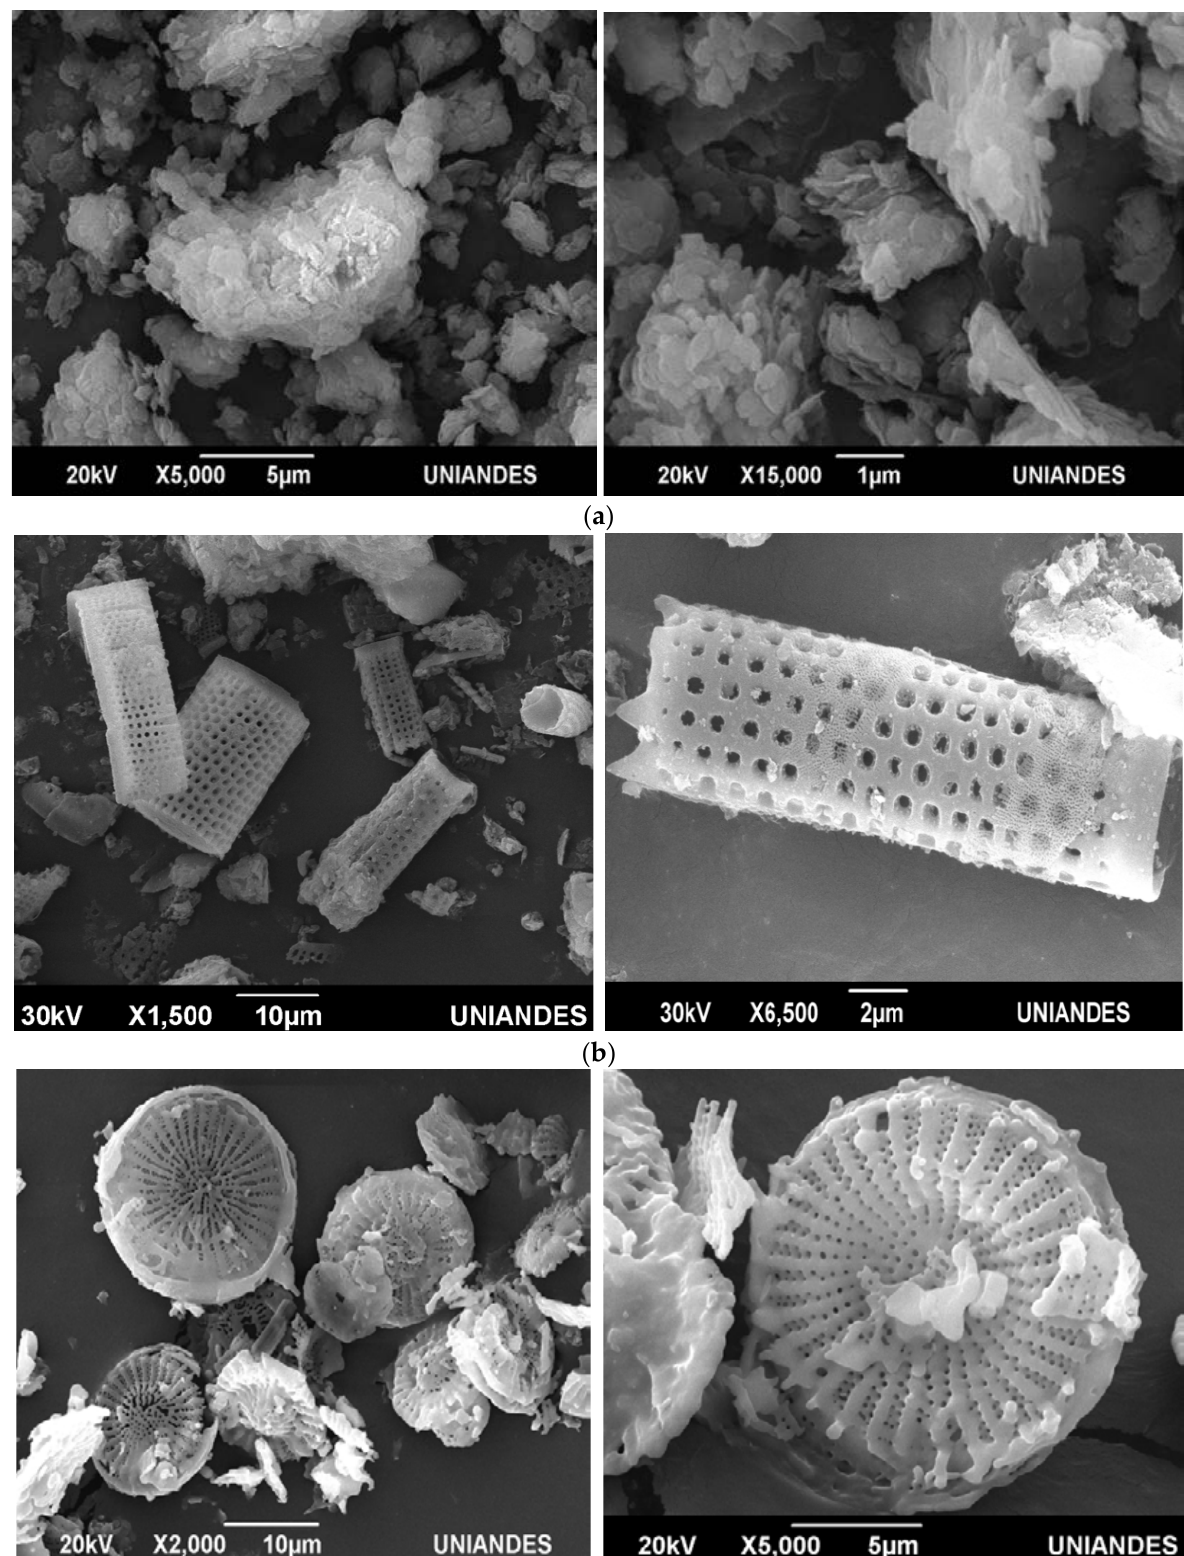
Figure 1. SEM images of: ( a ) kaolin; ( b ) Colombian diatom species; ( c ) Mexican diatom species.